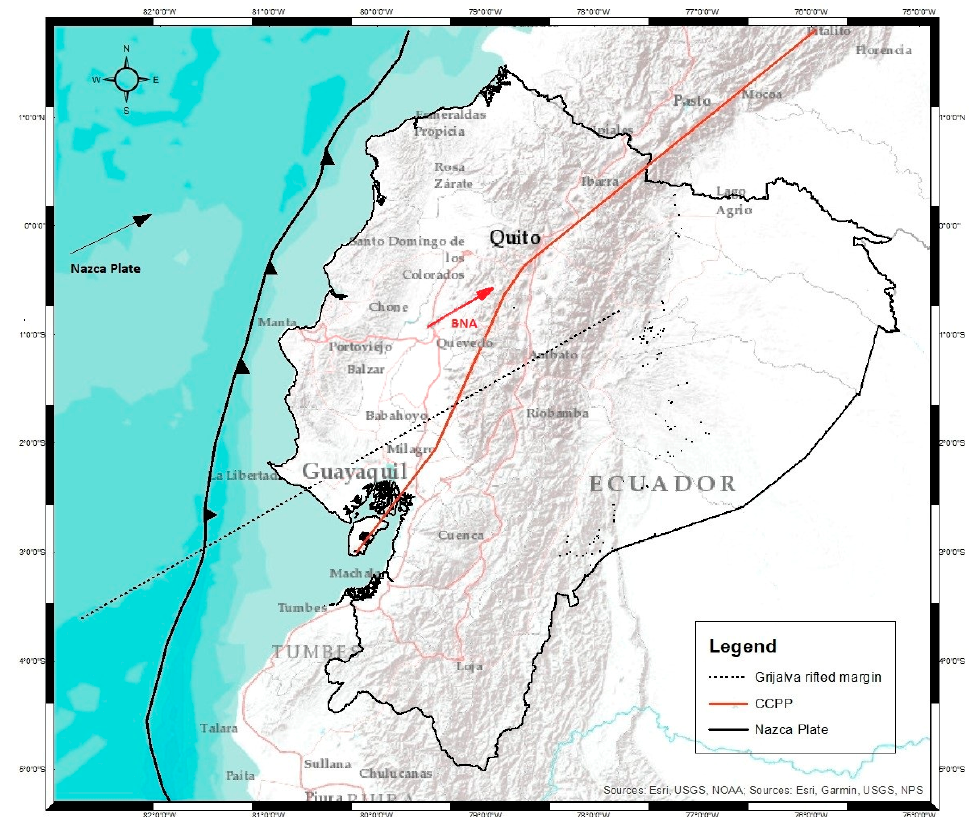
Figure 3. Diagram of the geodynamics of plates in the Ecuadorian territory. The thick black line shows the movement of the Nazca plate concerning the South American plate, and the continuous red line represents the division of the blocks of the South American SOAM plate. This is also represented by the movement of these blocks due to the convexity of the margin (black line with notches). We can observe how the Nazca plate converges—the northern Andean block moves along the right lateral displacement faults or reverse faults. The CCPP fault system continues in Colombia as the Algeciras fault (thick red line). Modification from [15].